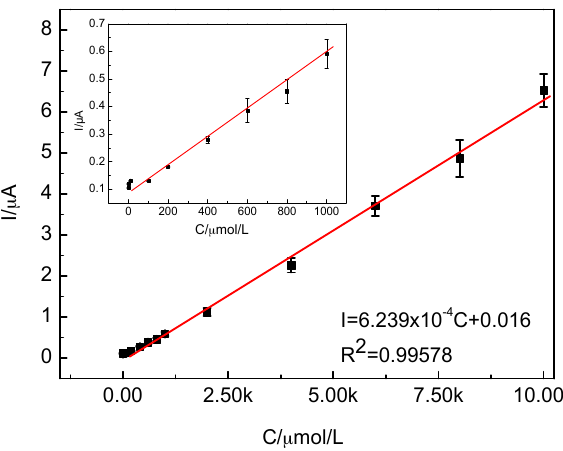
Figure 8. The relationship between the reduction peak current and H 2 O 2 concentration. The reduction peak current at the low concentration is shown in the inset.